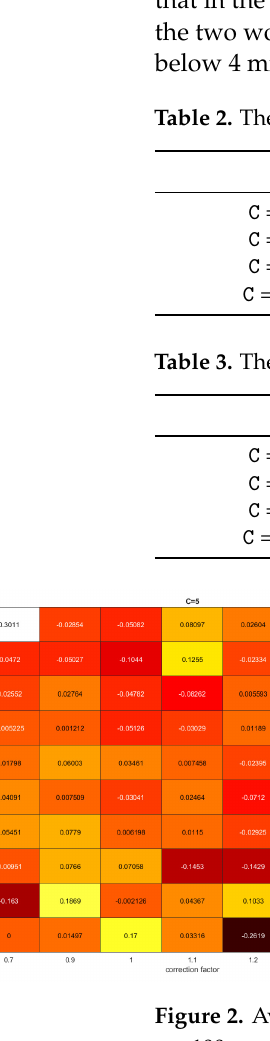
Figure 2. Average error with a 5 kg windowing as a function of the correction factor for C = 5 and C = 100 cases with the AdaBoost + SVR